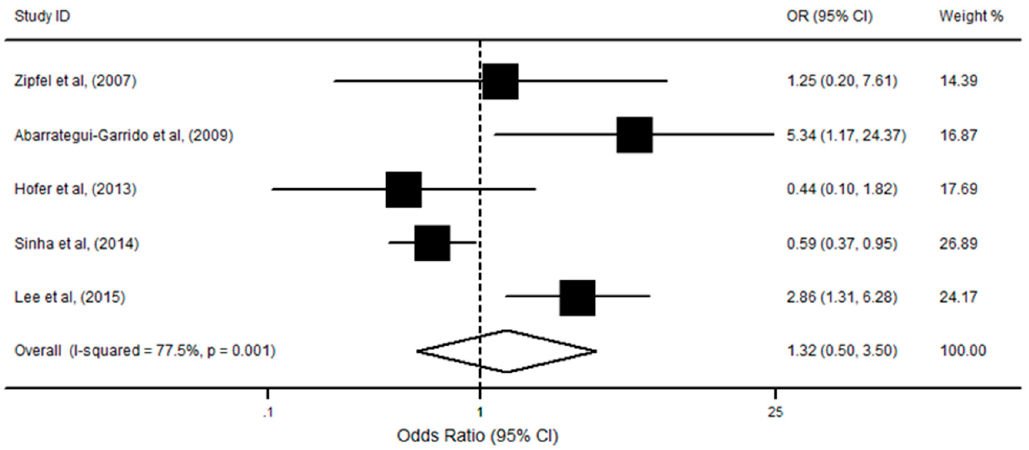
Figure 3. Forest plot on the association between CFHR1/R3 deficiency and aHUS risk. For each study, the estimation of OR and its 95% CI are plotted with a box and a horizontal line. The pooled odds ratio is represented by a diamond. The area of the black squares reflects the weight of the study in the meta-analysis.